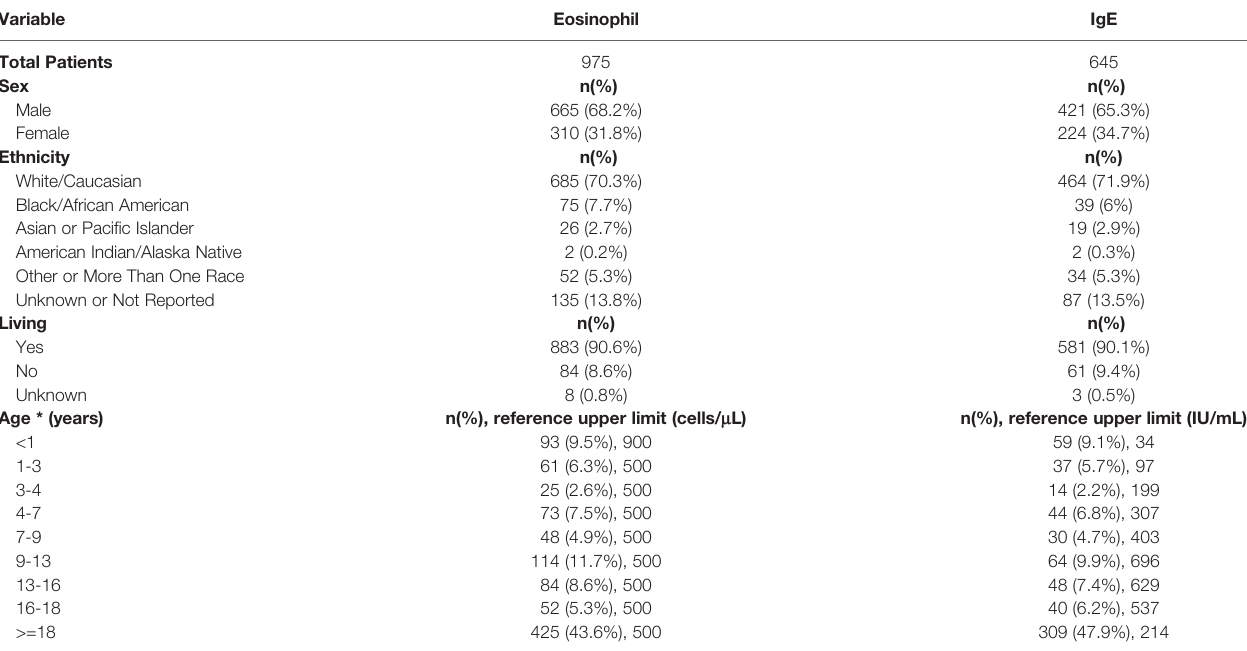
TABLE 1 | Demographic characteristics of selected “ Eosinophils ” and “ IgE ” cohorts.